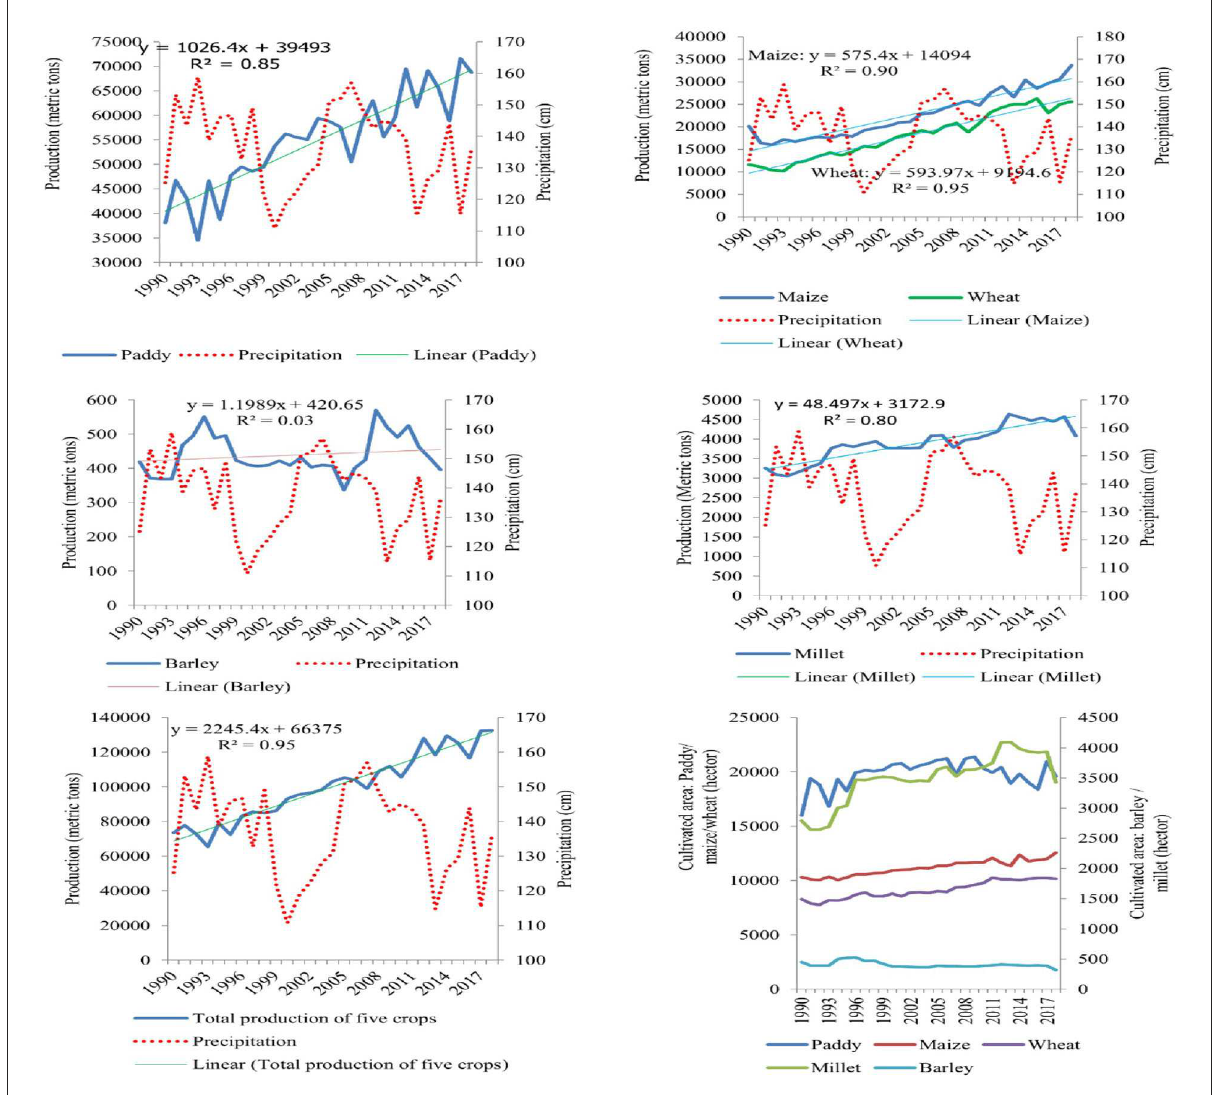
FIGURE1 Trend of production of five major cereal crops from 1990 to 2018 vs precipitation trend.